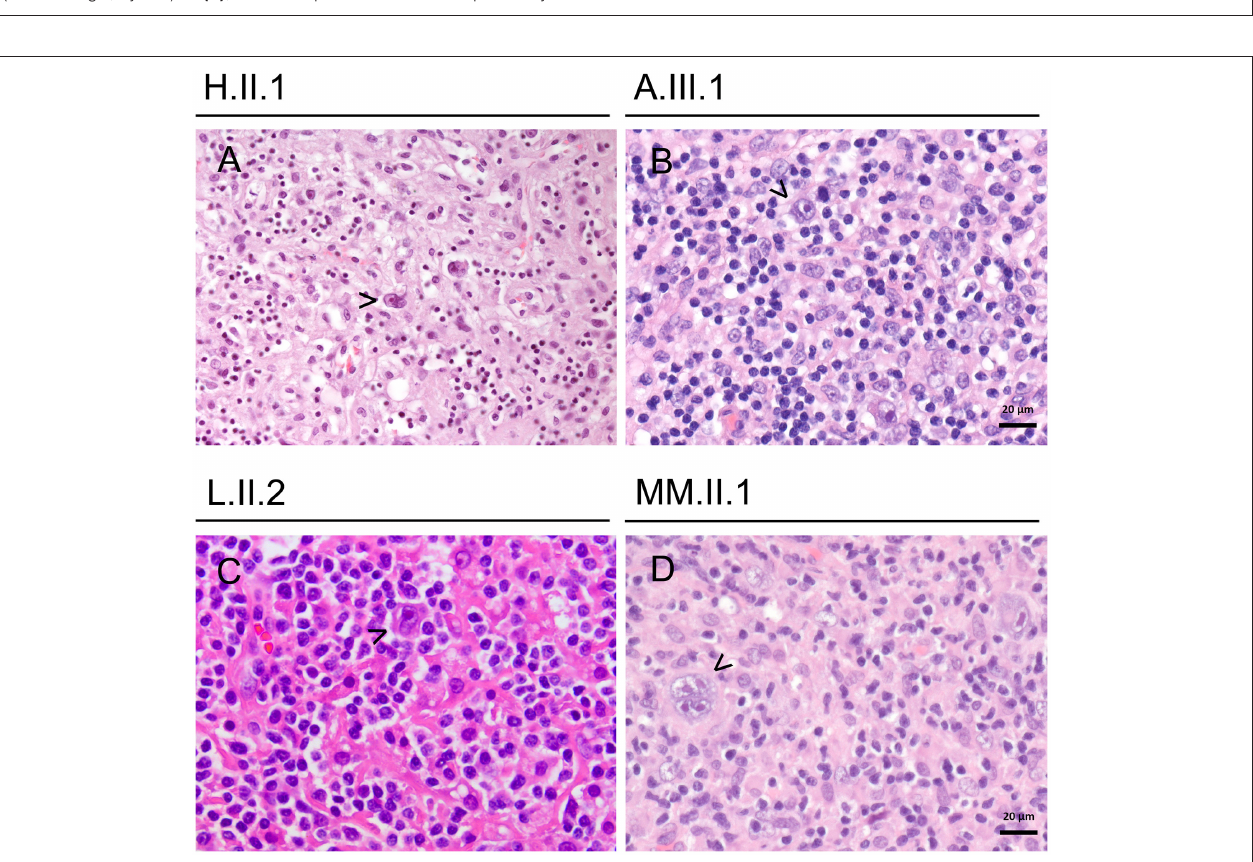
FIGURE 2 | Lymphomas in CTLA-4-insufficient-patients (A–D) showing classical Hodgkin lymphomas (mixed cellularity subtype), exemplary Reed-Sternberg cells are highlighted by arrowhead. All cases were EBV-associated.